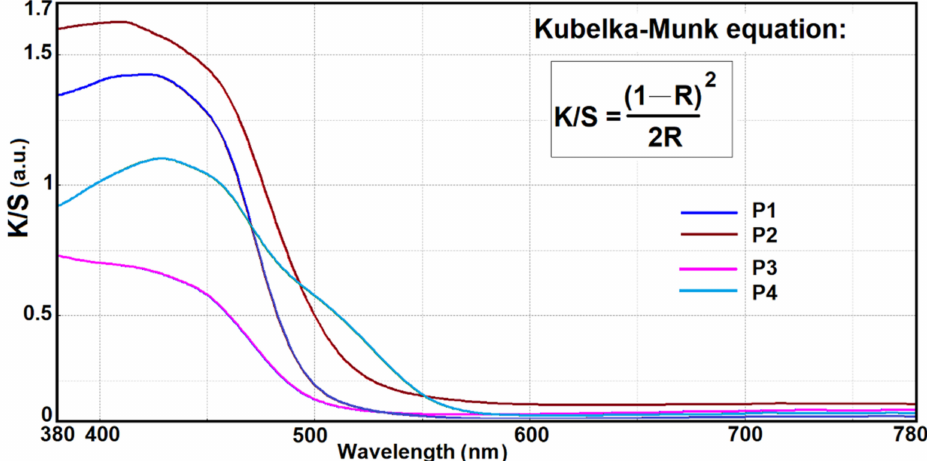
Figure 9. Color strength (K/S) of polyester textiles coated with hybrid materials and the Kubelka Munk equation, where K—absorption coefficient and S—scattering coefficient of the coated